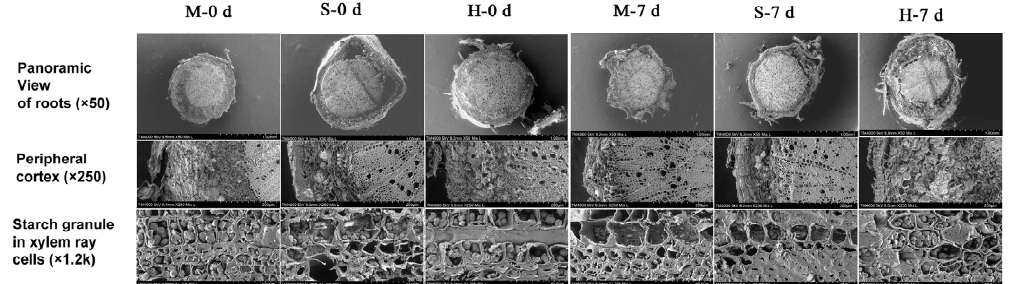
Figure 10. SEM observation and comparison of anatomical structure changes of roots (cross-section) of different peach rootstocks; the biggest differences between the two treatments (un-stressed control and 7 d of waterlogging) are the morphology of the peripheral cortex layer and the amount of starch granules in the xylem ray cells and pith cells. Abbreviations: M: Prunus persica, ‘Maotao’; S: Prunus davidiana, ‘Shantao’; H: ‘Hossu’. Root samples were collected under non-stressed condition (M-0, S-0, H-0) and on the 7th day (M-7, S-7, H-7) of WT. “ × 50”, “ × 250”, and “ × 1.2 k” refer to different magnifications of SEM when observing different parts of samples.